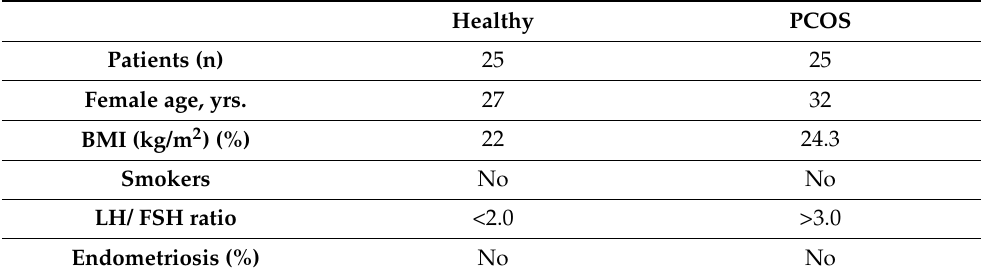
Table 1. Characteristics of the healthy donors and PCOS patients. Healthy PCOS Patients (n) 25 25 Female age, yrs. 27 32 BMI (kg/m 2 ) (%) 22 24.3 Smokers No No LH/ FSH ratio <2.0 >3.0 Endometriosis